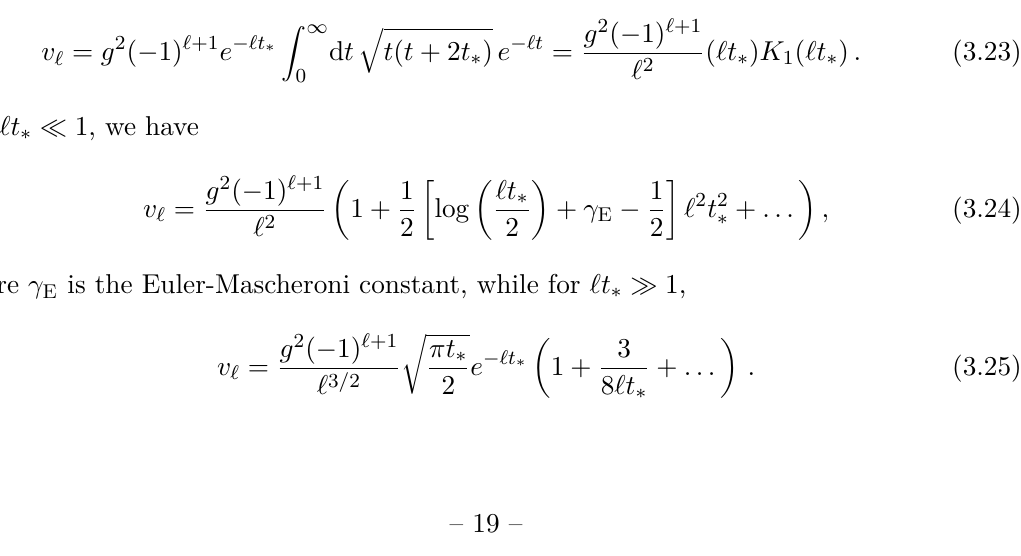
proves a good approximation for (cid:15)